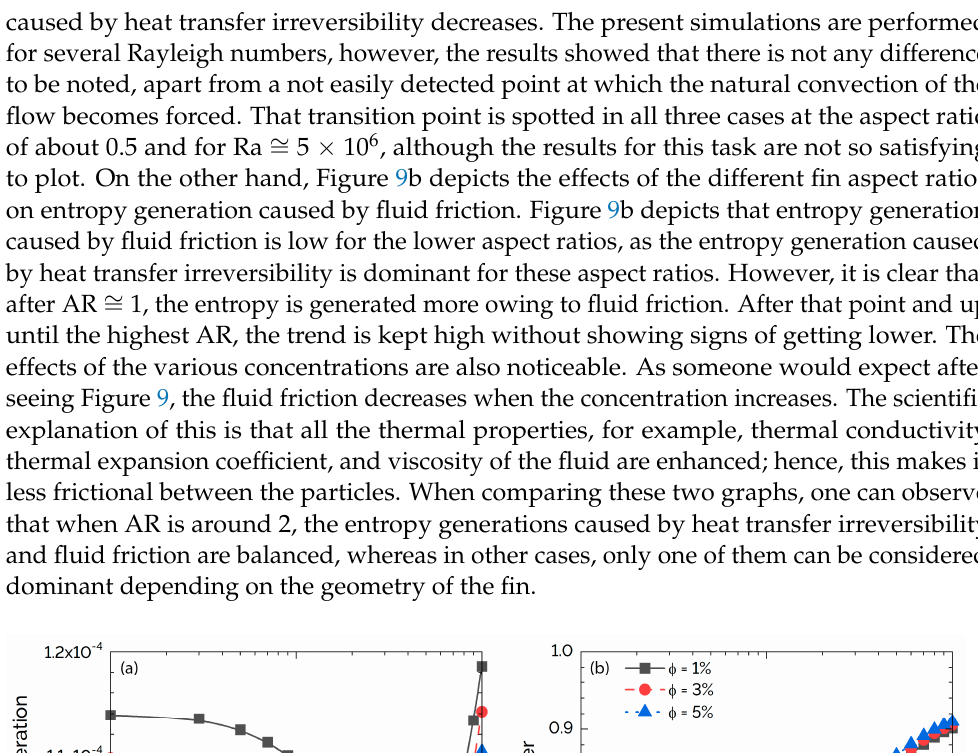
Figure 11. Contour plots of Bejan number for Ra = 10 5 , Re = 1000, and fin area fraction of 0.05 for three fin aspect ratios. ( a ) AR = 0.5, ( b ) AR = 4, and ( c ) AR = 10.